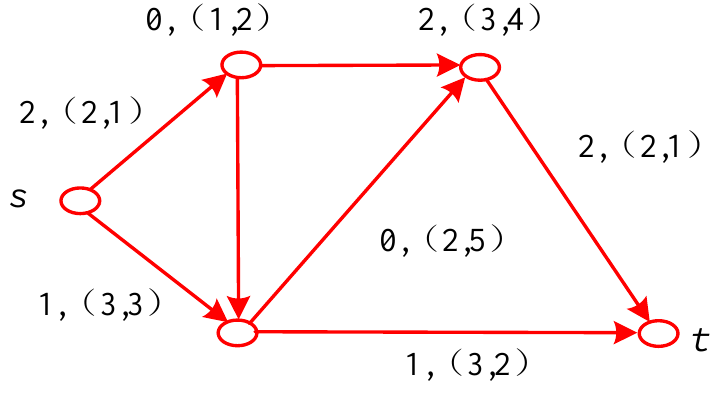
Figure 1. Schematic diagram of fee network. The energy flow and network flow problems of regional building energy systems have similarities. Referring to the relevant regulations on the conversion, distribution and consumption of building energy in China, the network flow theory is applied to solve the energy circulation of regional building energy system. The solution to the minimum cost maximum flow in the network flow problem is to find the feasible flow with the minimum total cost in the cost network, and the feasible flow also refers to the maximum flow of the cost network [20,21]. For the energy circulation of the regional building energy system, it means that on the basis of reaching the regional load standard, try to make the hot water configuration, air conditioning, heating, and other aspects of the buildings in the region scientific and the energy consumption is the lowest. The research analyzes the regional building energy system of Shanghai, and the data is from the local statistical yearbook. Figure 2 refers to a schematic diagram of the energy flow of the regional building energy system. The main realization methods of energy allocation are energy demand, energy conversion, and energy supply, and the relationship between them is connected by directed line segments. The characteristics of regional building energy circulation include three levels, namely directionality, capacity, and hierarchy. For the directionality, the regional building energy mainly completes a series of processes such as energy supply, conversion, distribution and consumption through the three processes of energy supply, energy conversion and energy demand, so that the energy utilization process has a certain directionality. The energy flowing in each directed line segment has an upper limit and a lower limit. The upper limit of energy generally refers to the maximum value